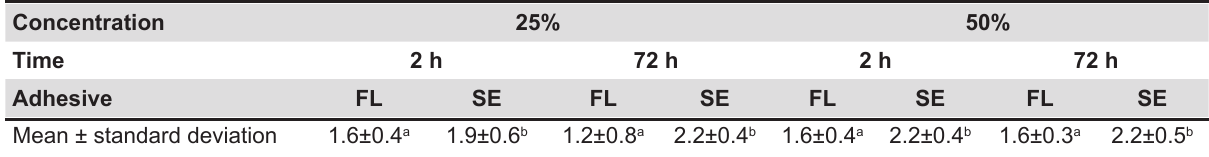
*Values with same letter are not significantly different (p>0.05). FL= Optibond FL; SE= Optibond SOLO Plus